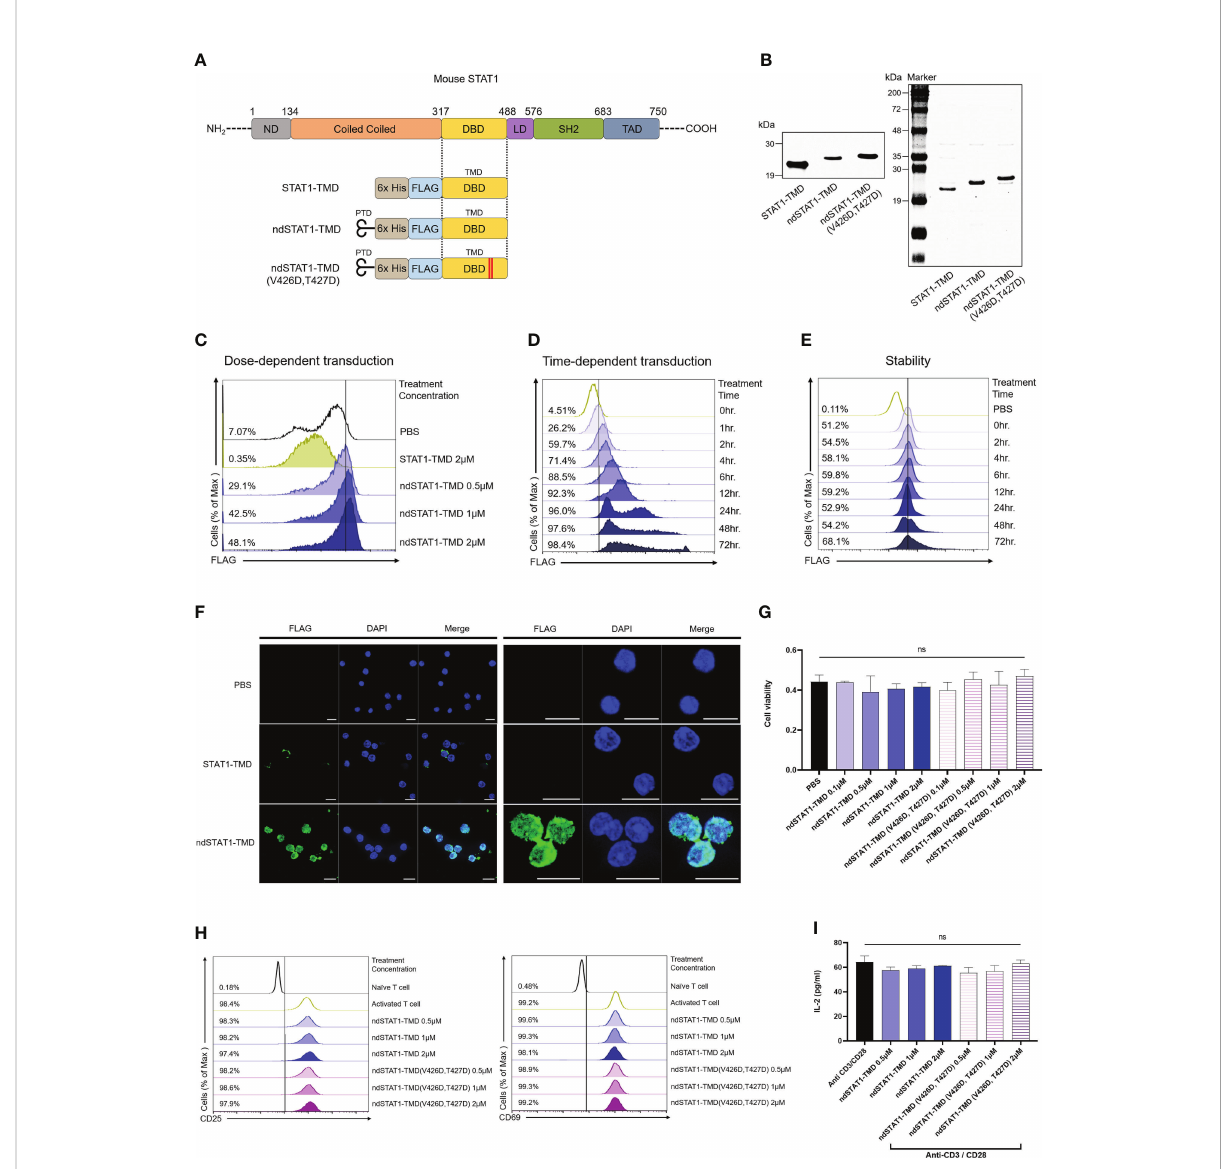
FIGURE 1 Generation of nucleus-deliverable ndSTAT1-TMD and veri fi cation of its intra-nuclear transduction kinetics without cellular cytotoxicity. (A) Protein structure of STAT1-TMD without Hph-1-PTD, ndSTAT-TMD, and ndSTAT1-TMD (V426D, T427D) with mutated valine 426, and threonine 427. PTD, protein transduction domain; nd, nucleus-transducible; TMD, transcription modulation domain; DBD, DNA binding